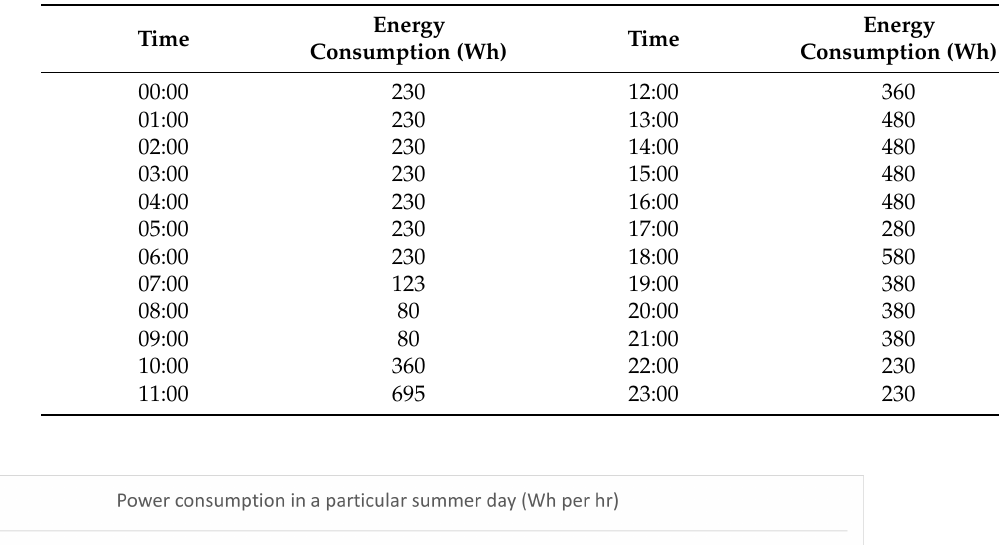
Table 9. Initial load profile created for the project (summer).